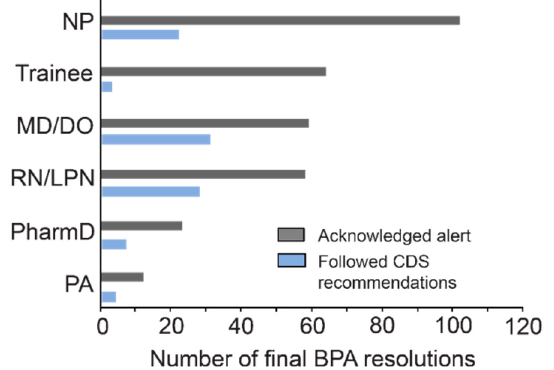
Figure 6. CDS resolution sorted by healthcare provider. Trainees included fellows, physician residents, and medical students. CDS recommendations were followed if provider ordered alternative drug, removed order, or adjusted dose. Acknowledged reasons were previously tolerated, failed other treatments, session ended before action, and other. MD: Doctor of Medicine, DO: Doctor of Osteopathic Medicine, NP: Nurse Practitioner, PA: Physician